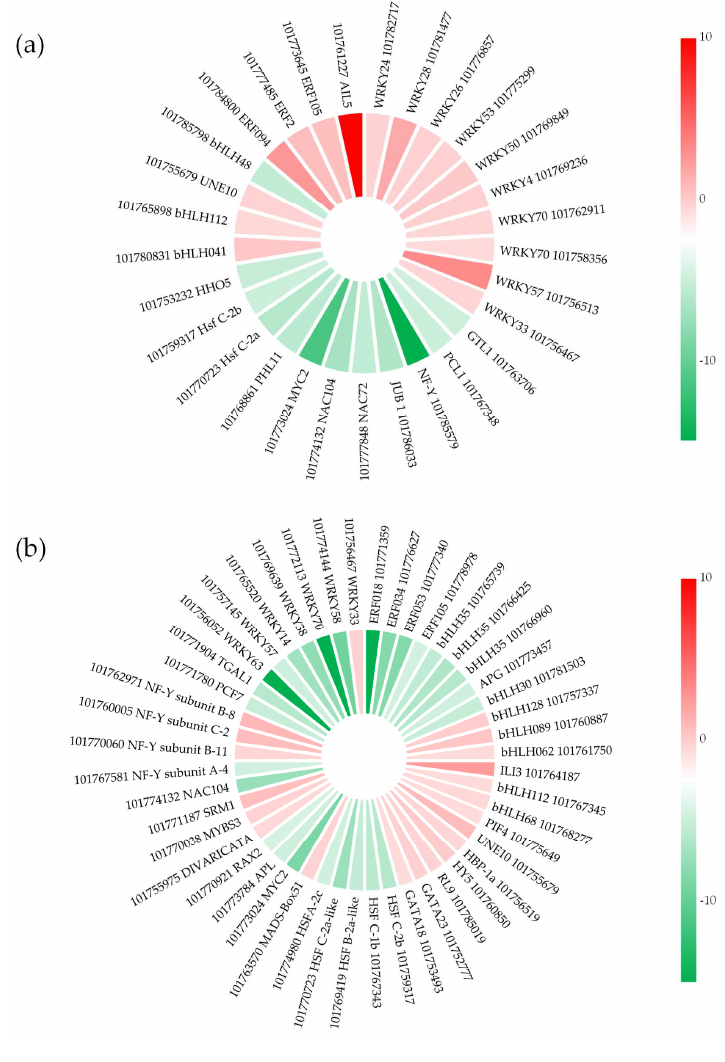
Figure 4. Differential expression of transcription factor salt-sensitive ( a ) and salt-tolerant ( b ) accessions. Color key indicates the log 2 FoldChange.